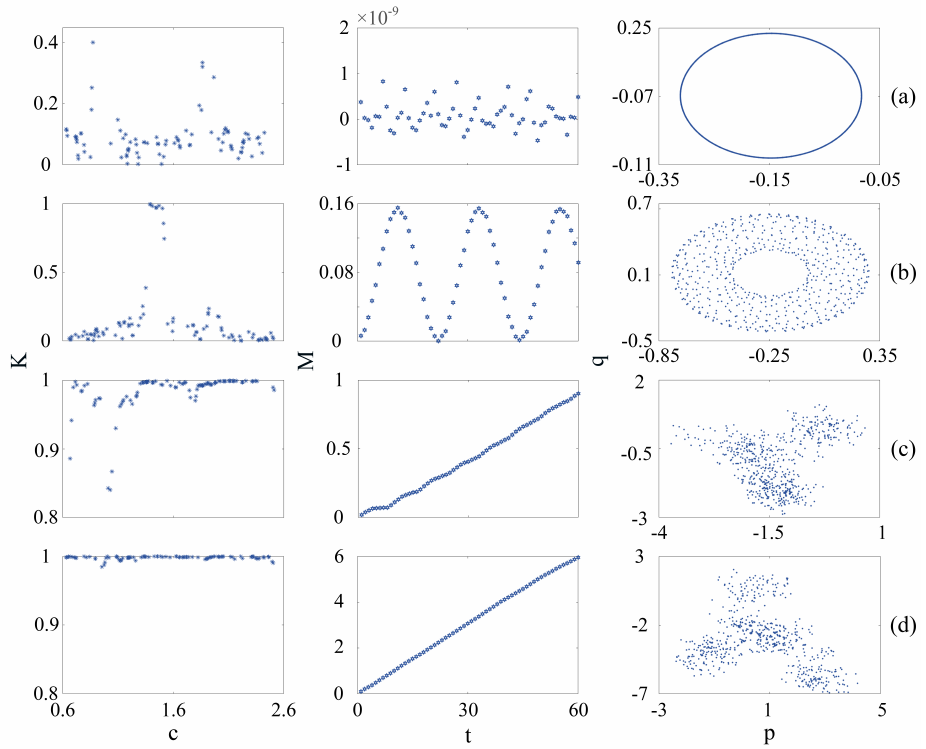
Figure 5. The 0–1 test for observing the different dynamic states, where k = 1 ns − 1 and ( a ) τ = 1.6 ns ; ( b ) τ = 2.3 ns ; ( c ) τ = 4.6 ns ; ( d ) τ = 4.6 ns and k = 3.5 ns − 1 . The parameters in this figure are the same as in Figure 4. K : asymptotic growth rate; M : mean square displacement; p and q : translation variables; c : random constant; t : sampled